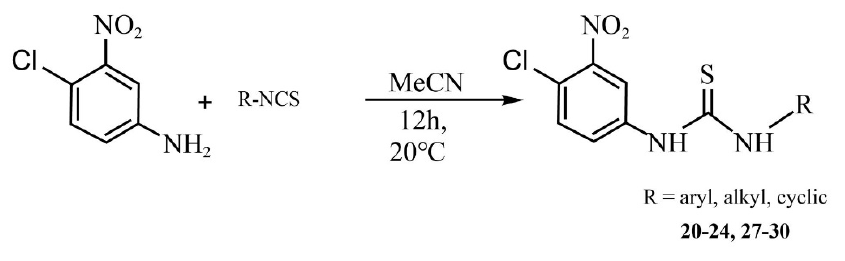
Table 1. Cytotoxicity and anti-HIV activity of 4-chloro-3-nitrophenylthiourea derivatives 1 – 30 . Comp. R Comp.